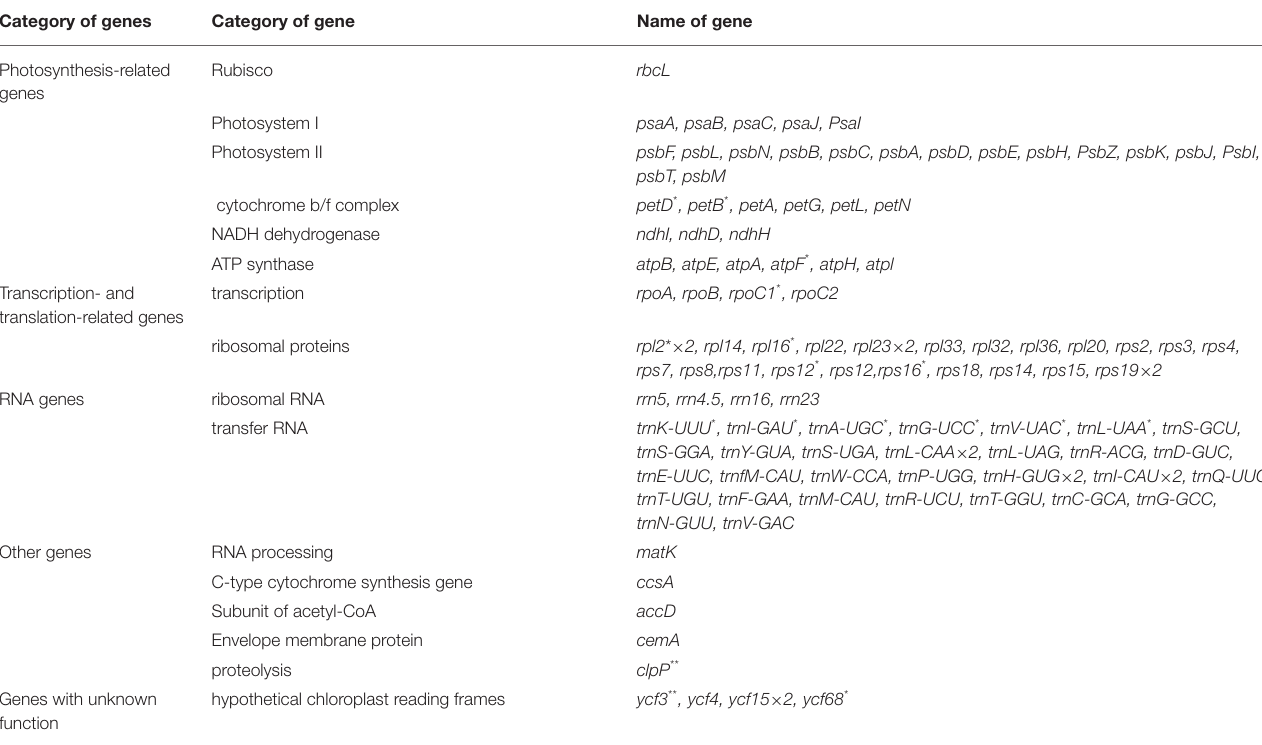
TABLE 3 | Functional annotations of cp genes Zygophyllum based on KOG annotation. The ndhH gene is absent in Z. obliquum . Category of